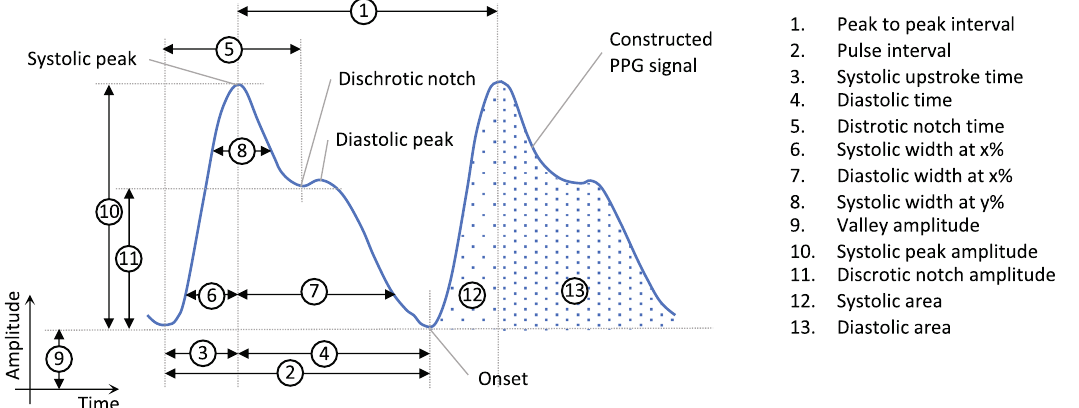
Fig. 5 Commonly extracted features from the PPG signal for BP estimation. The fi gure displays a representative PPG signal during a time interval of two pulse waves, i.e., approximately two